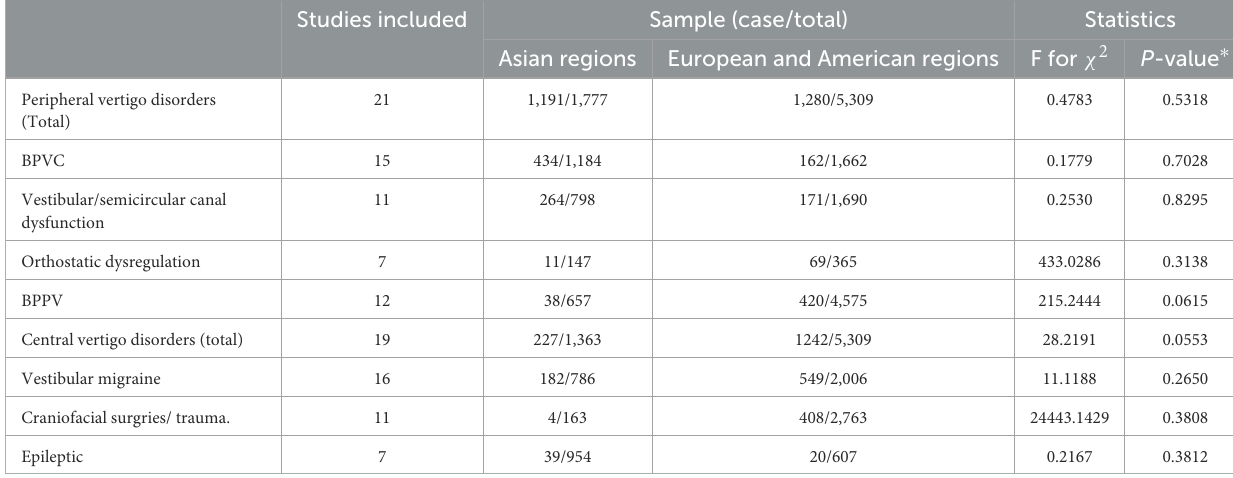
TABLE 7 The prevalence of common diagnosis in different area. Studies